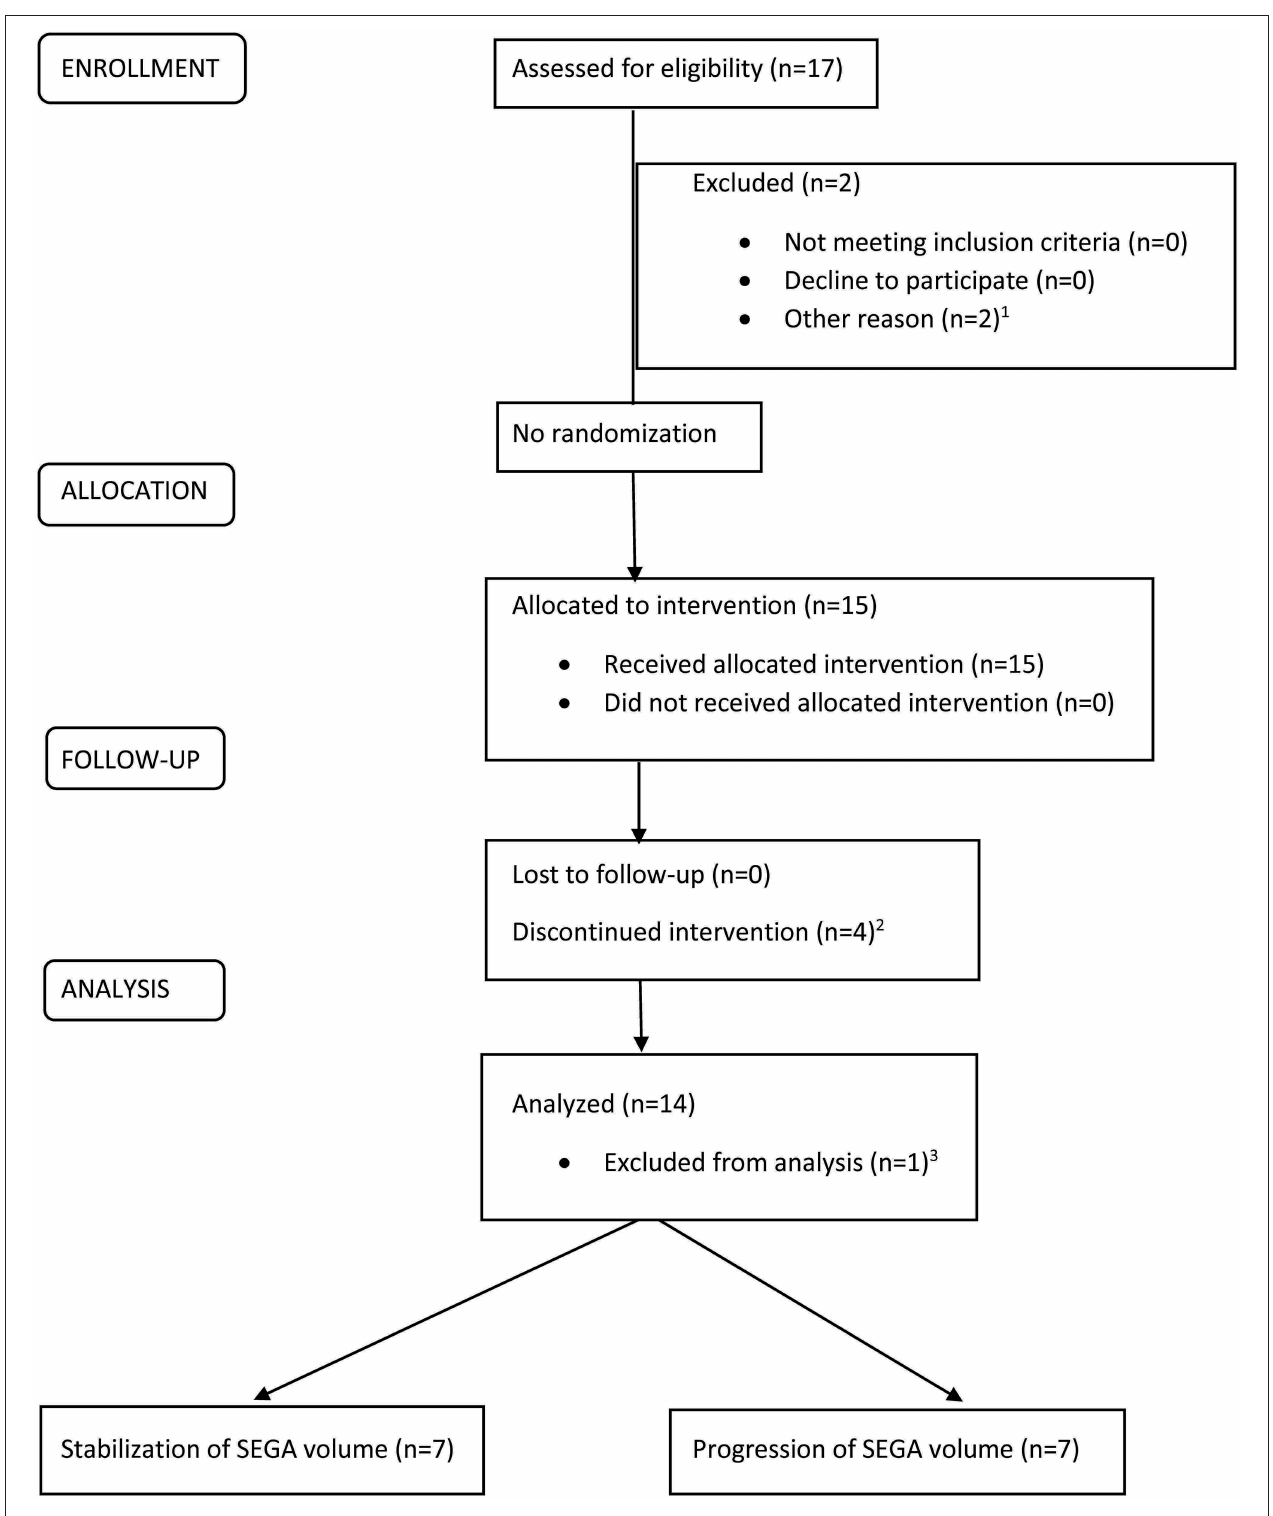
FIGURE 1 | CONSORT flowchart for a single-arm, open-label, prospective intervention to evaluate the efficacy and safety of maintenance therapy with everolimus in patients with TSC and SEGA.